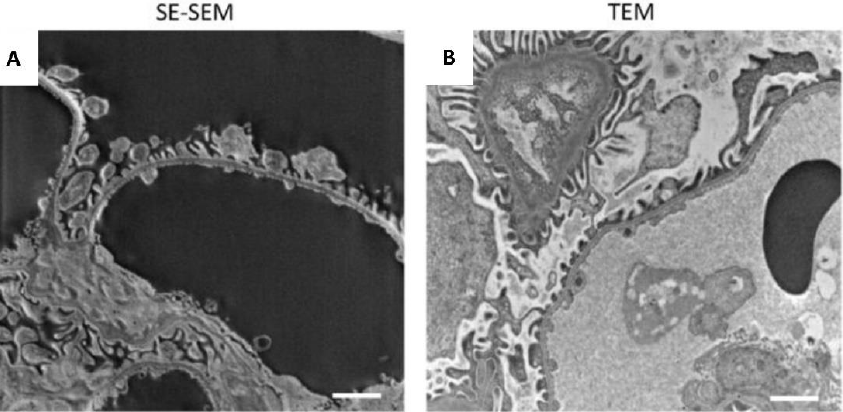
Figure 4. Comparison of the SE – SEM image with TEM image: ( A ) representative image of renal ultrastructure taken with SE – SEM or ( B ) with TEM. Scale bars: 1 µm. ultrastructure taken with SE–SEM or ( B ) with TEM. Scale bars: 1 µ